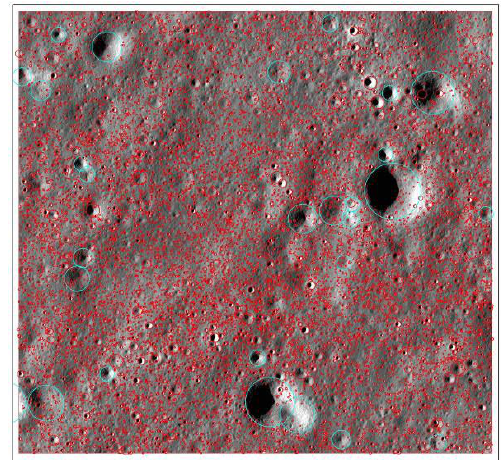
Figure 6. Identified craters in CE-4 landing site.